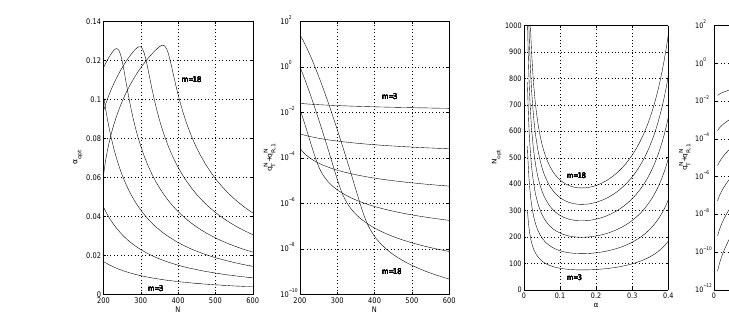
Figure 8. N opt versus α (left graph) and q N versus α (right graph) for r 0 = + q N R, 1 T 0 . 1 and m = 3 , 6 , 9 , 12 , 15 and 18